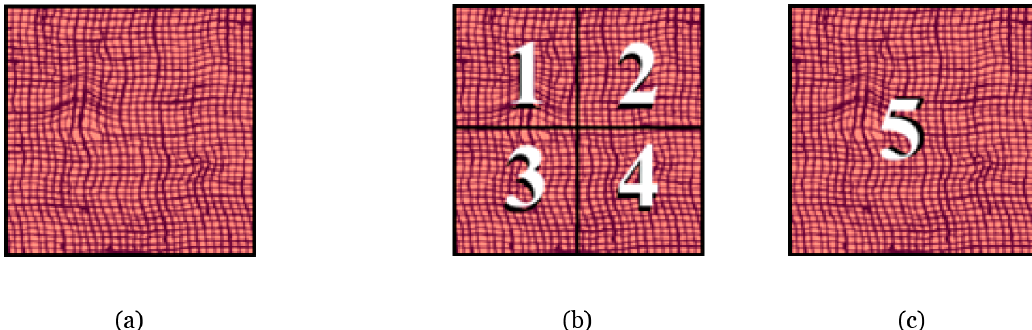
Figure 4. Example of ( a ) the original image. ( b ) The four local partitions and ( c ) the global partition. These five images generate two spatial scales: four local ( b ) and one global, adding spatial information to the extracted features.